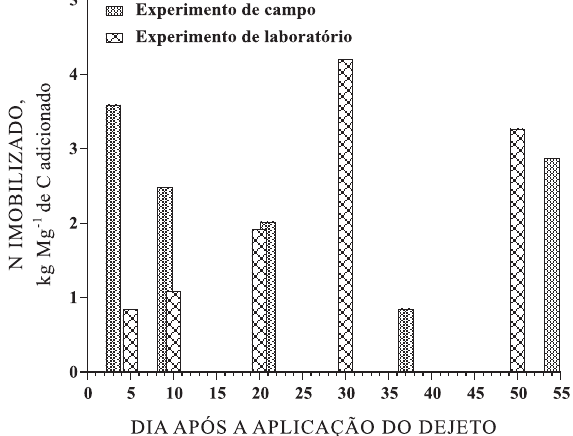
Figura 4. Quantidade de N imobilizado para cada Mg de C adicionada com palha de aveia em campo e em